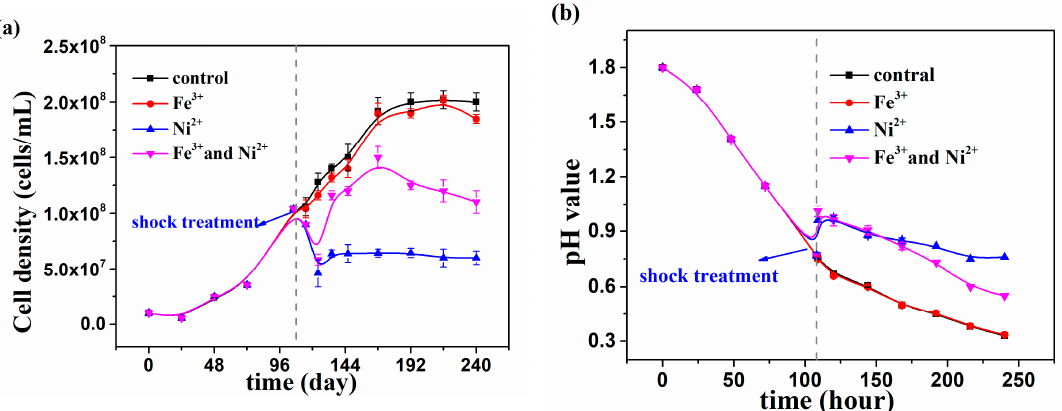
Figure 3. The cell density ( a ) and pH value ( b ) of At. thiooxidans A01 under shock treatment of individual and joint Ni 2+ and Fe 3+ .